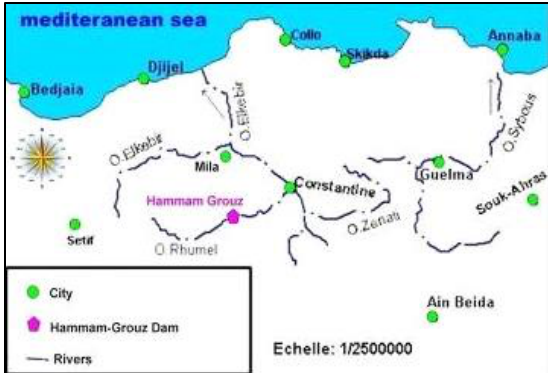
Figure 2. Geographic and hydrographic situation of Hammam Grouz dam in the northeast region of